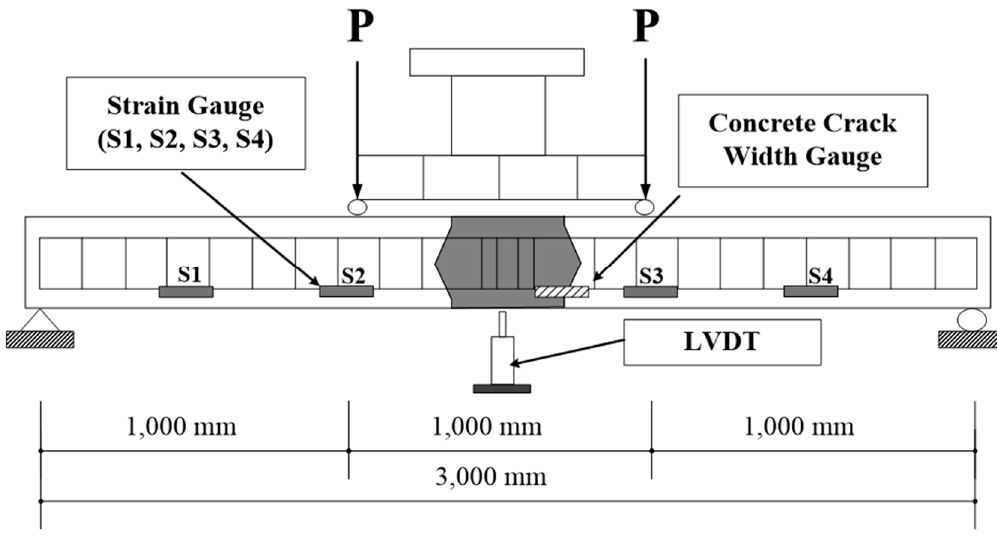
Figure 2. Test setup for the modular specimen.